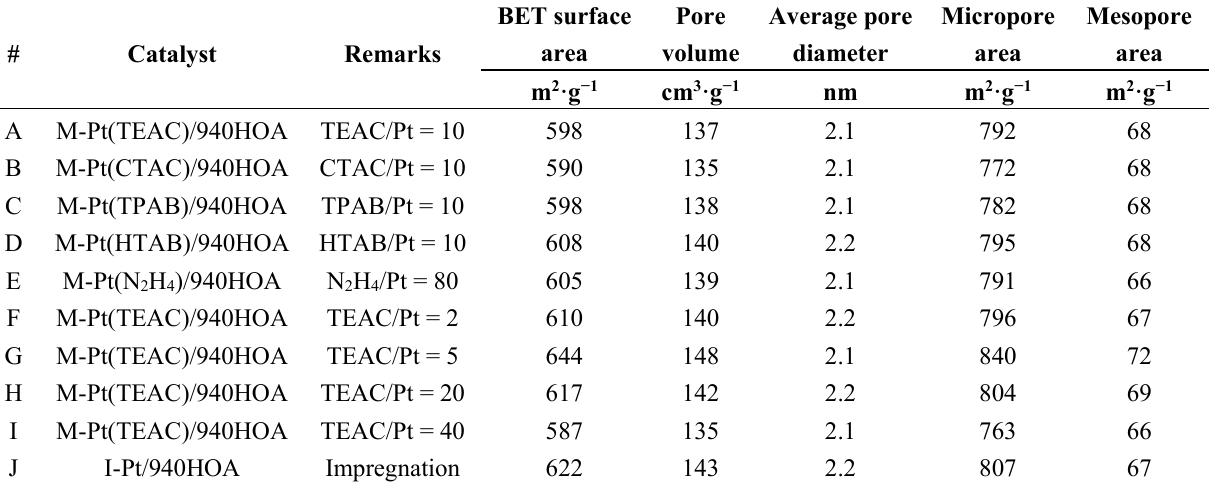
Table 2. Surface area, pore volume, and average pore diameter of Pt-loaded zeolite